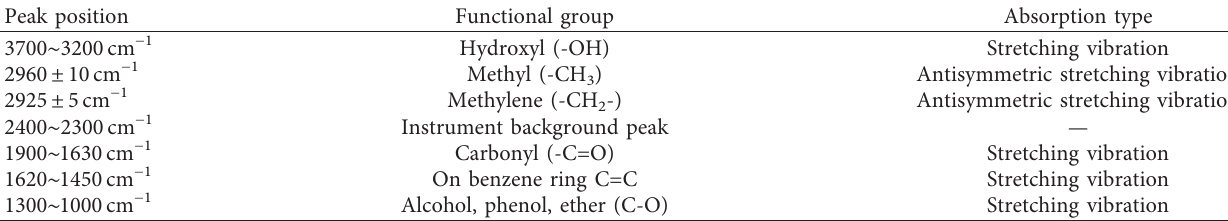
Table 2: Infrared peak position